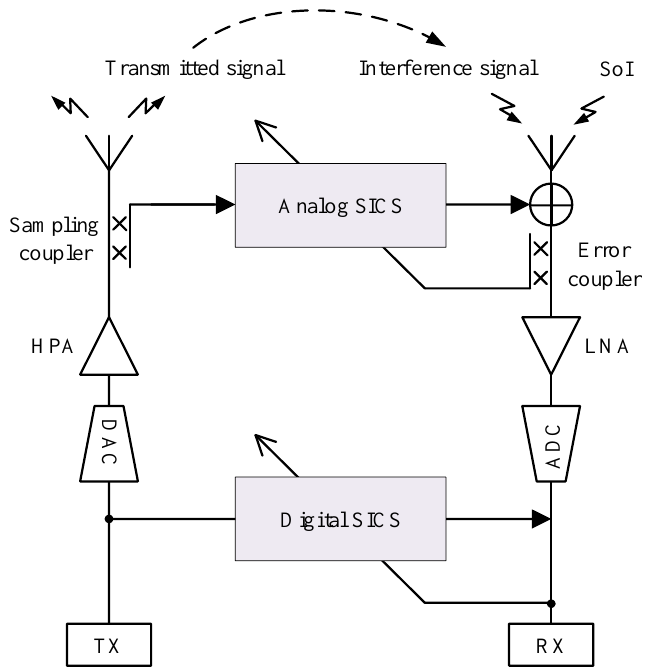
Figure 6. A typical digital SIC topology.